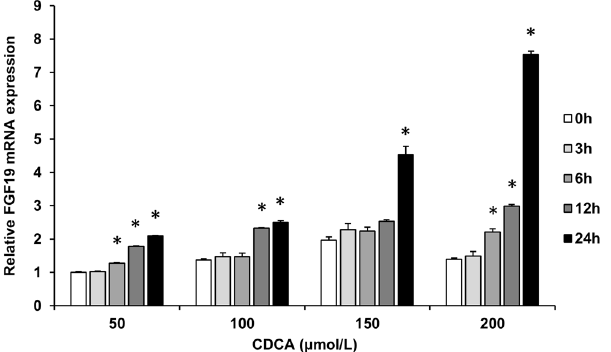
Figure 7. Time course of the effect of different concentration CDCA on FGF19 mRNA levels in LS174T cells. The level of FGF19 mRNA in cells incubated with 50 μ mol/L CDCA for 0 h was set at 1, and the other values were adjusted proportionately. Data are mean ± SEM, n = 3. * P < 0.05, compared vs. 0 h of respective